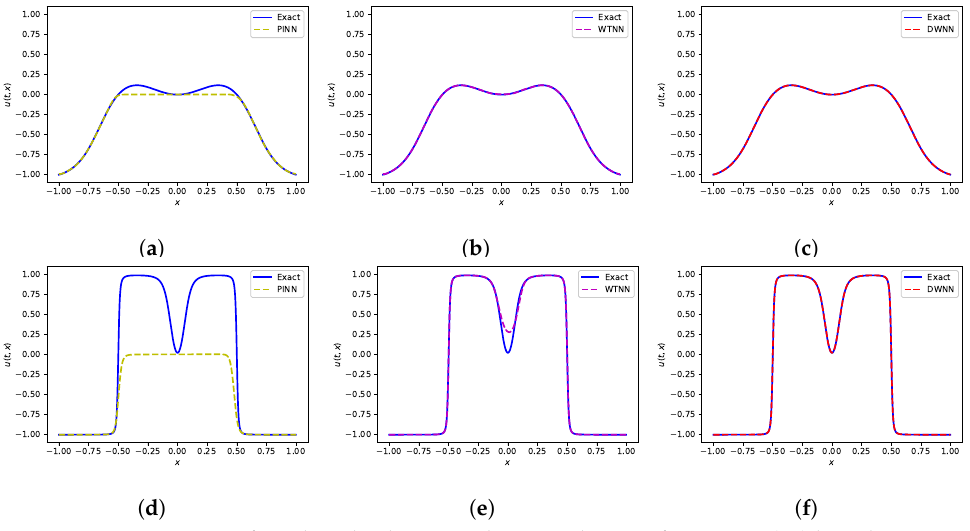
Figure 15. Comparison of predicted solution and exact solution of Equation (45) based on PINN, WTNN and DWNN. ( a – c ) the comparison of predicted PINN solution, WTNN solution, DWNN solution and exact solution at t = 0.15, respectively. ( d – f ) the comparison of predicted PINN solution, WTNN solution, DWNN solution and exact solution at t = 0.95,